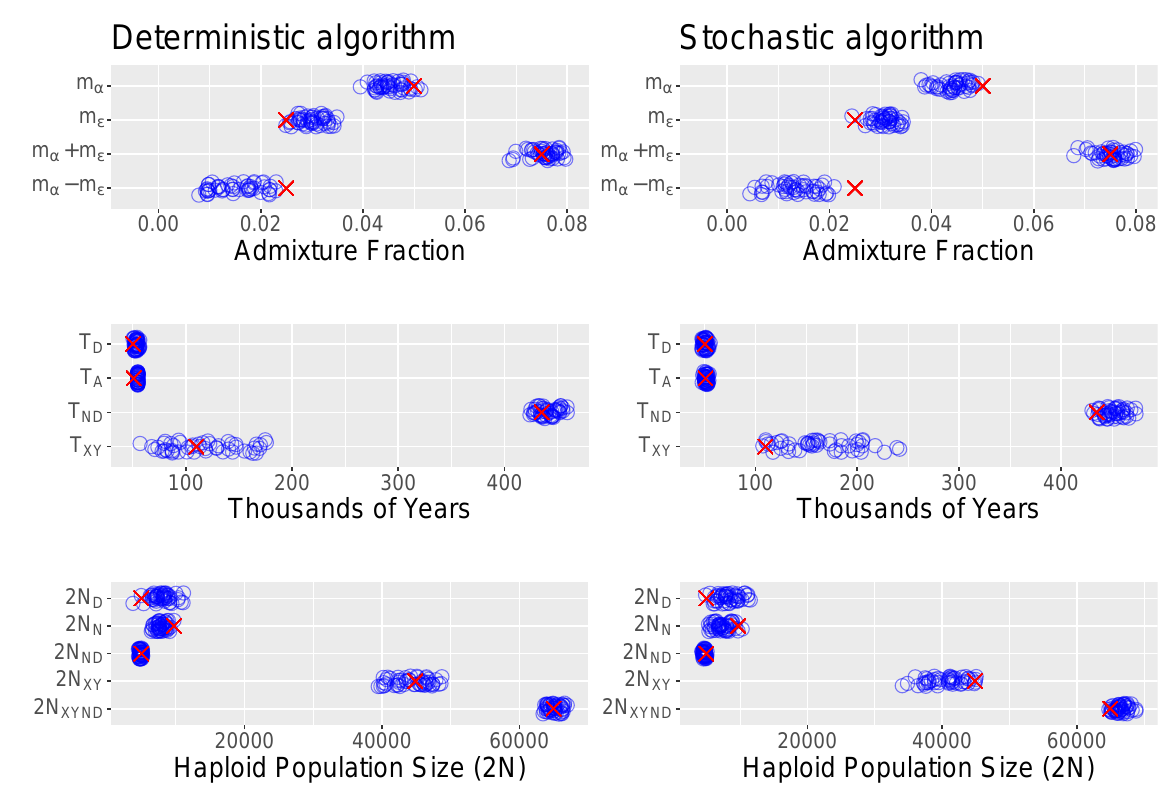
Figure 7 – Parameter estimates from 50 simulated data sets, using the deterministic and stochastic algorithms. Blue circles are estimates and red crosses are the true parameter